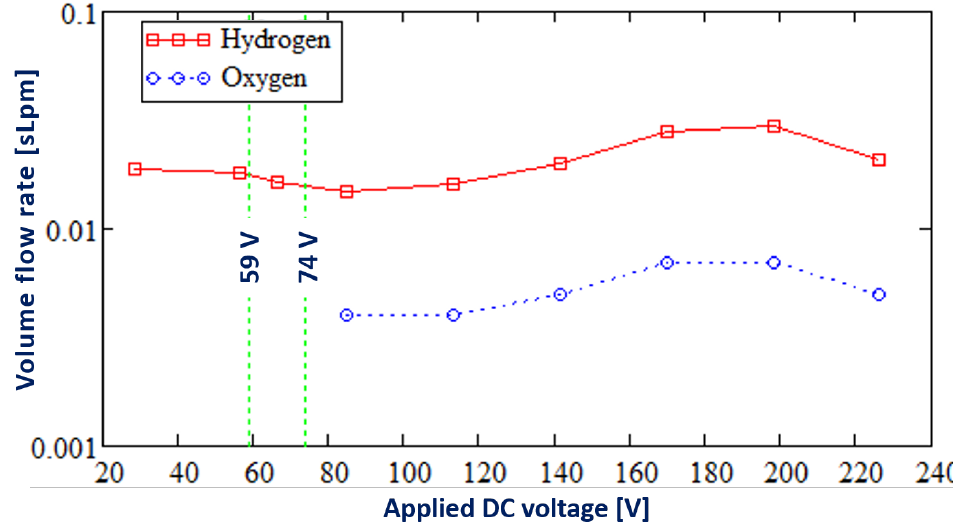
Figure 5. The composition of the gas mixture evolved from the discharge electrode.